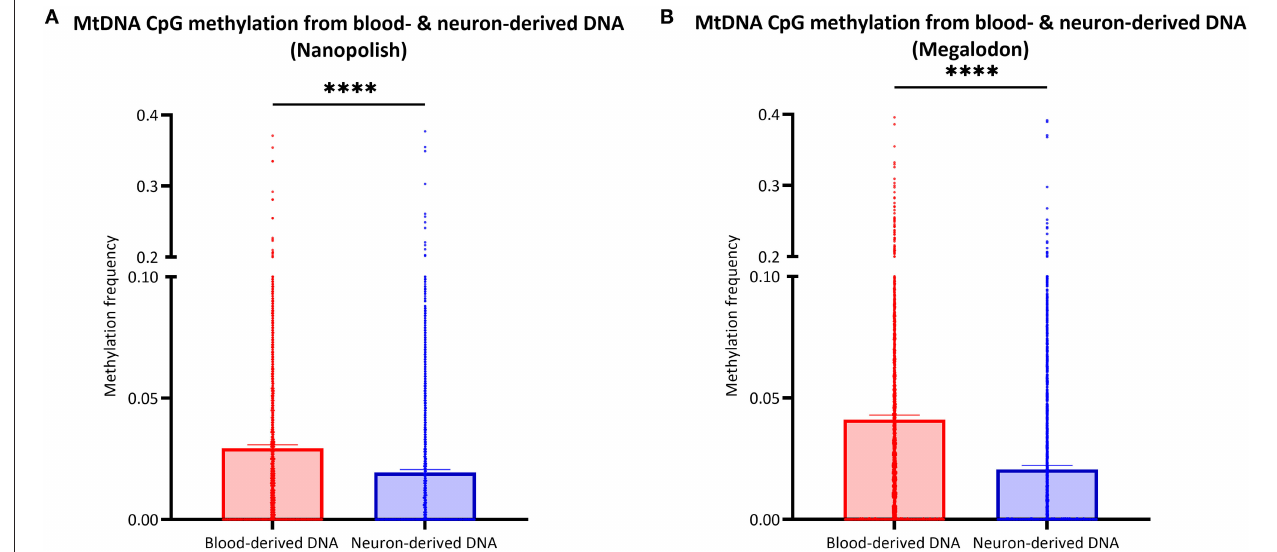
FIGURE 5 | Comparison of mtDNA CpG methylation between blood- and neuron-derived DNA. (A,B) The bar plot shows the mtDNA CpG methylation from blood- or neuron-derived DNA (iPSC-derived midbrain neurons) which was either detected with Nanopolish (A) or Megalodon (B) . Bars indicate means and 95% confidence interval. The asterisks represent the level of significance (* p ≤ 0.05, ** p ≤ 0.01, *** p ≤ 0.001, **** p ≤ 0.0001), p -value = Mann Whitney U -test performed for pairwise comparisons, blood-derived DNA is indicated in red and neuron-derived DNA in